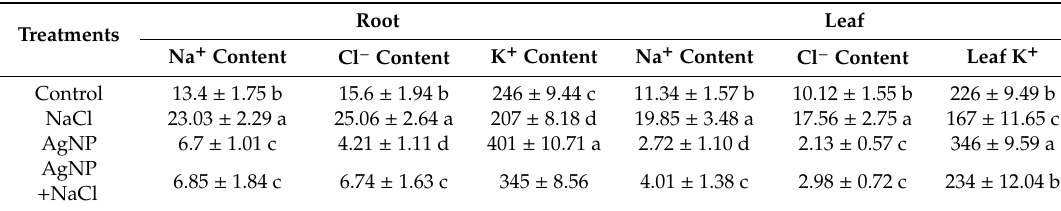
Table 3. Root and leaf Na + , Cl − (mg g − 1 DW) content, root and leaf K + content (mM) in wheat ( Triticum aestivium ) exposed to salt stress (100 mM NaCl) and supplemented with silver nanoparticles (AgNPs; 300 ppm) at 30 days after sowing. Data fallowed by the same letter within the column are not significantly di ff erent by LSD test at ( p <